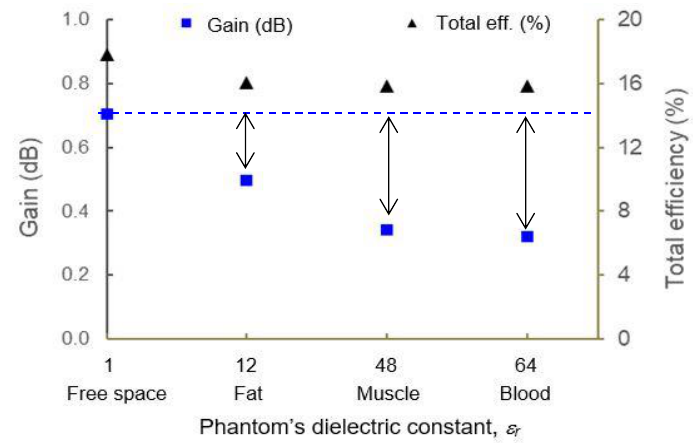
Figure 16. Magnetic surface currents along the x -axis (radiating edge). As the values of surface currents are similar for all cases, this factor can be omitted. It can be observed that when surface current is constant, high E-field intensity (V/m) for higher  r and  case is mainly due to the increase in Z in in lossy medium.